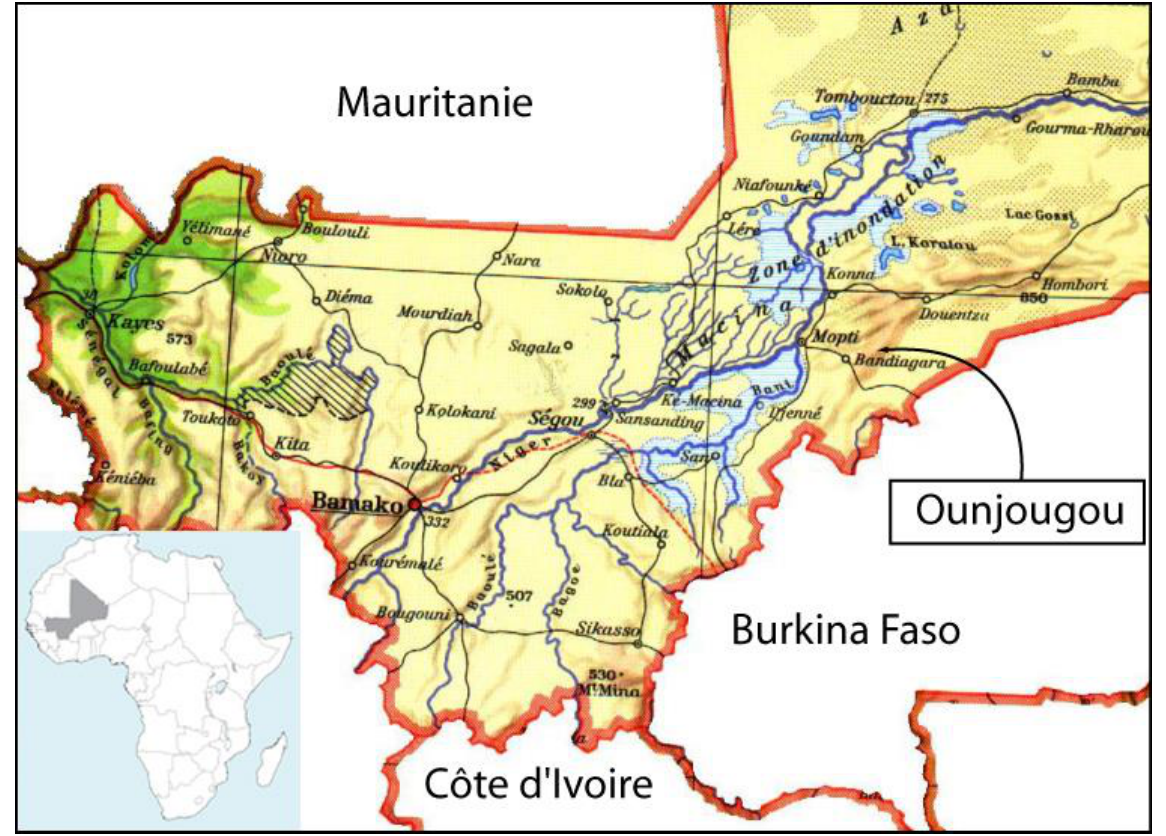
Figure 1. Location of Ounjougou